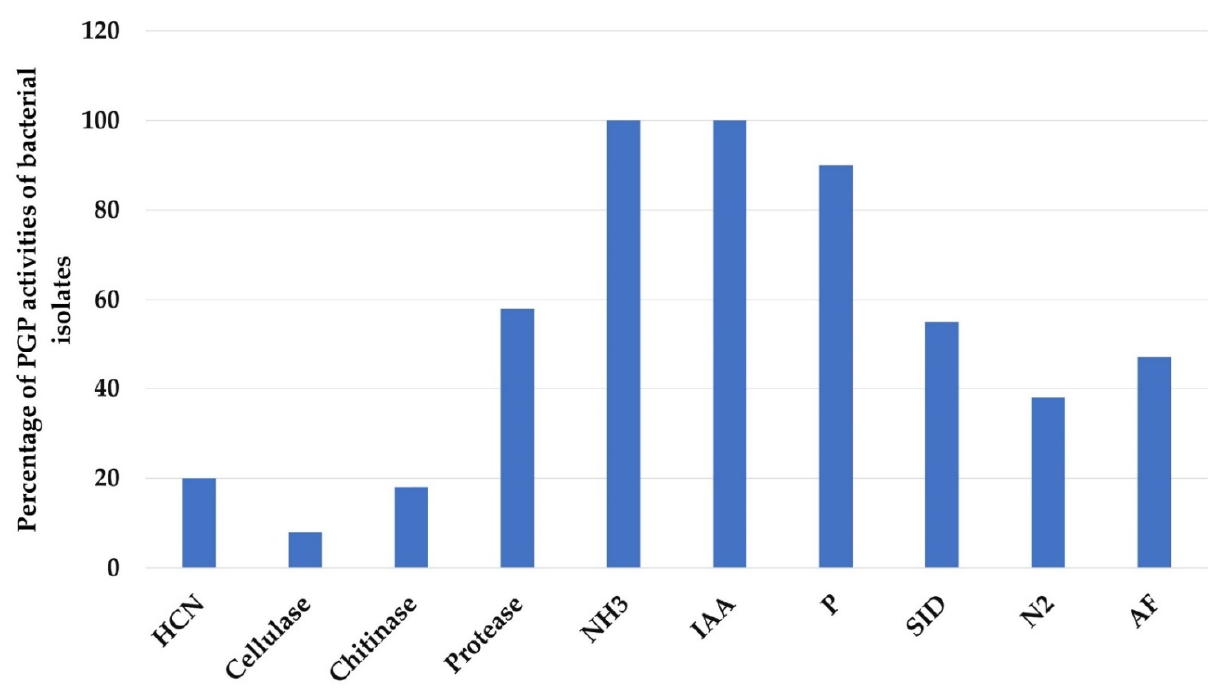
Figure 4. Percentage of plant growth promoting (PGP) activities of bacterial isolates.